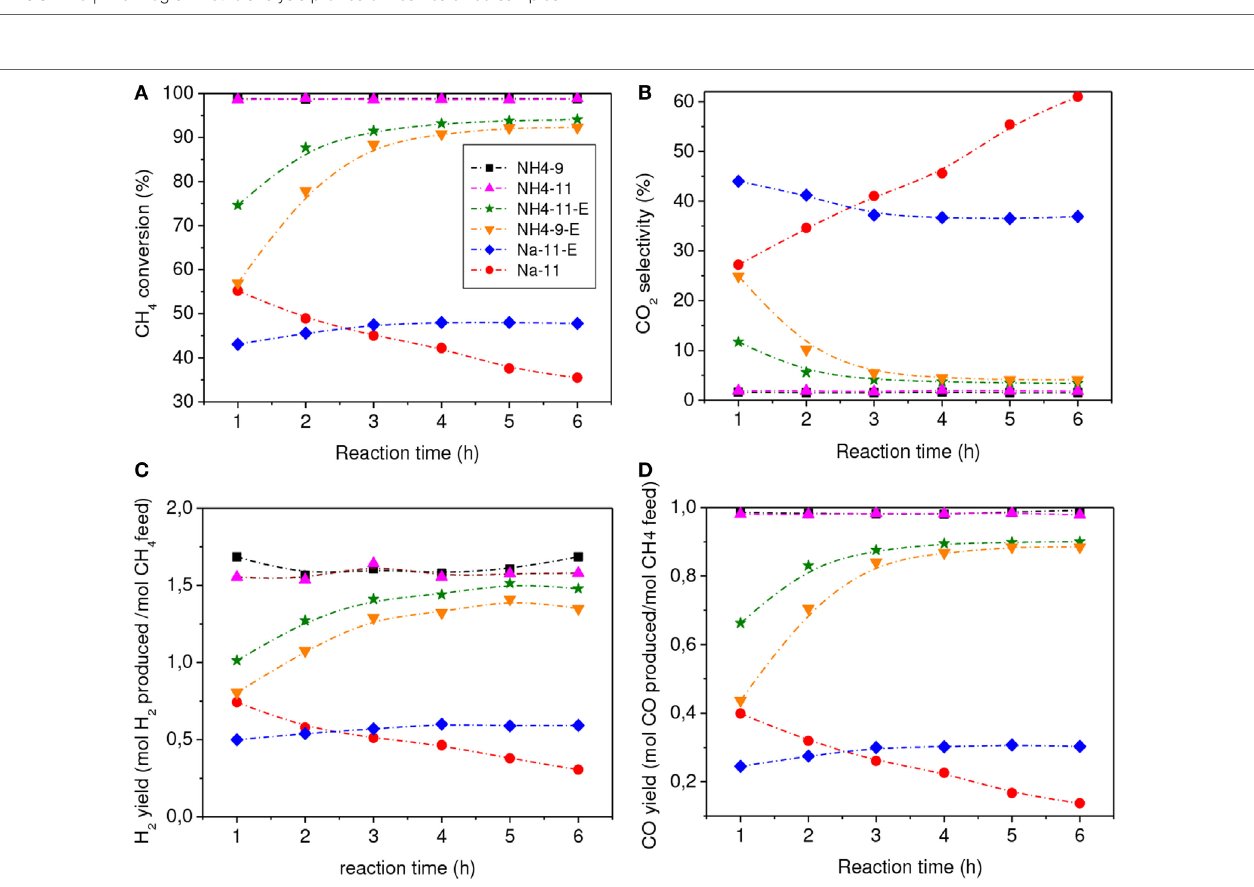
FigUre 6 | Activity parameters of catalysts for partial oxidation of methane to syngas [900°C, 36,600 mL N /h·g, 40% CH 4 , 20% O 2 , and 40% N 2 (molar)]. (a) CH 4 conversion, % (b) CO 2 selectivity, % (c) H 2 yield, and (D) CO